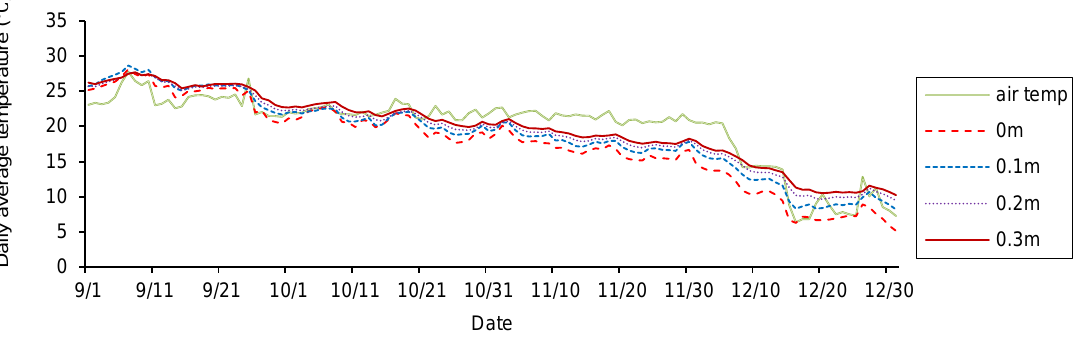
Figure 3. Diurnal variations in the air temperature and the greenhouse soil temperature in the warming season.